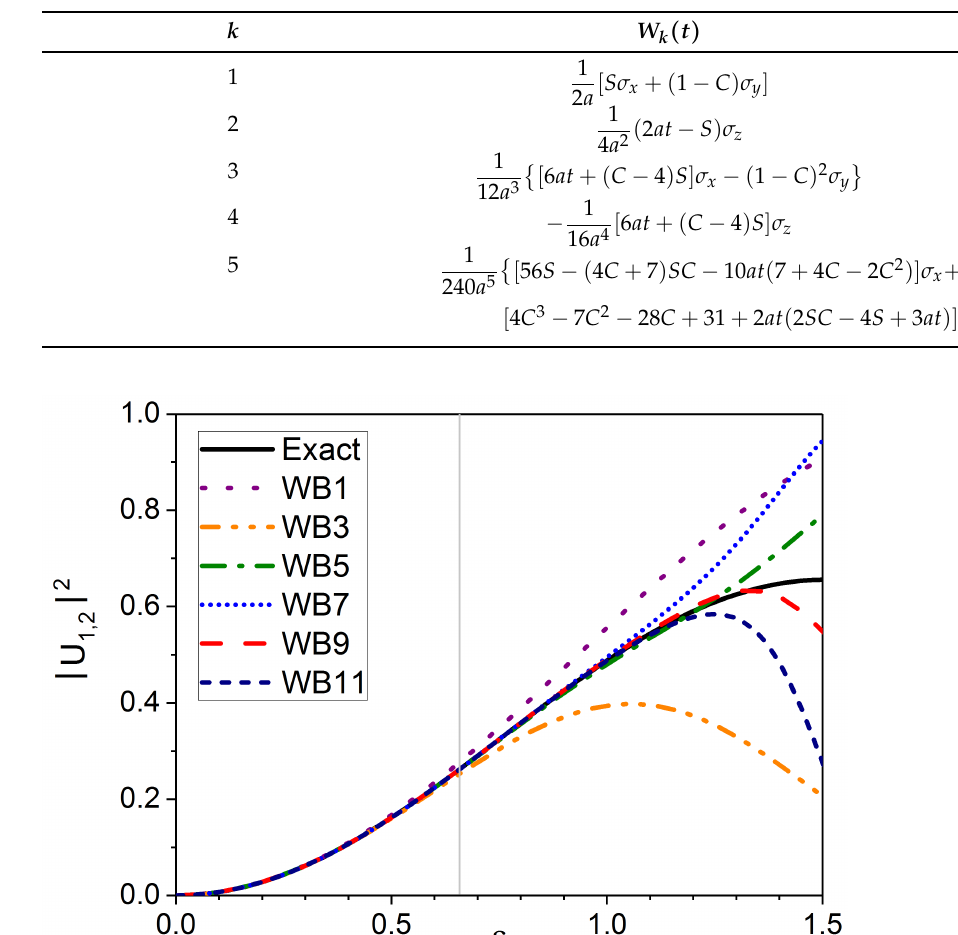
Figure 2. Accuracy of Wilcox–Bellman product expansion up to order eleven as a function of the ratio ε / a , with a = 1. The quantity plotted is the squared modulus of the non-diagonal element of the matrix. The vertical grey line stands for the convergence lower bound ε =